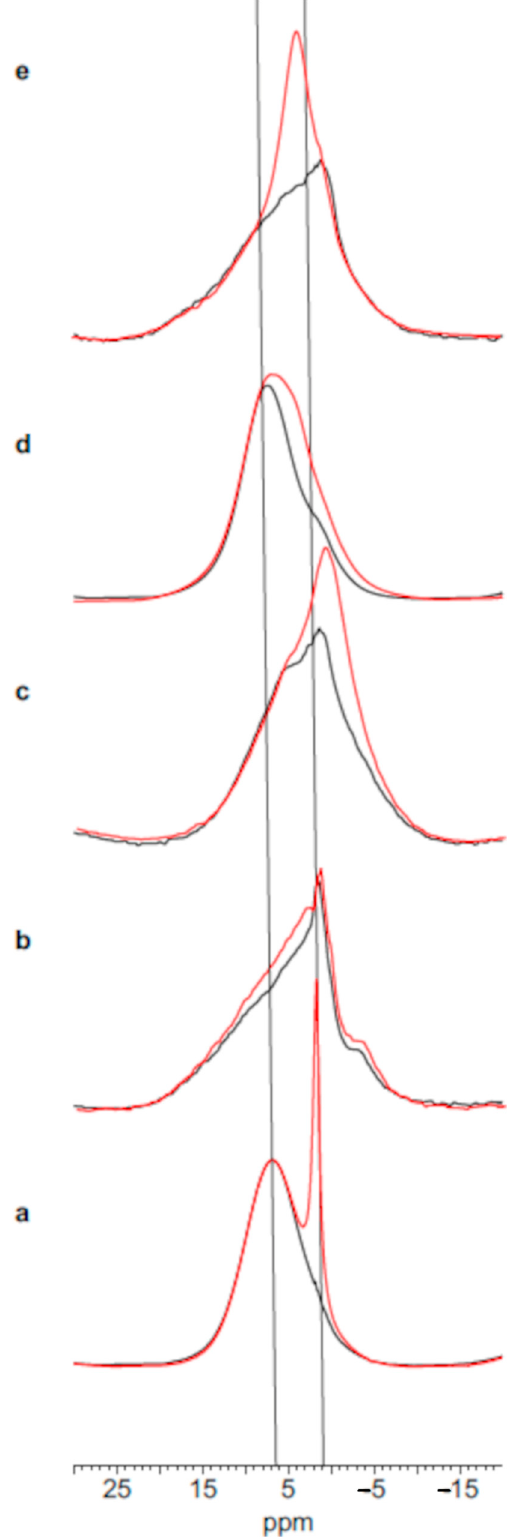
Figure 7. 1 H MAS spectra of wB ( a ), wAC ( b ), pB ( c ), pAC_meso ( d ), and pAC_micro ( e ) as prepared (red lines) and after heating at 150 °C for 12 h (black lines). The vertical lines serve as a visual guide for the positions 1.7 and 7 ppm.